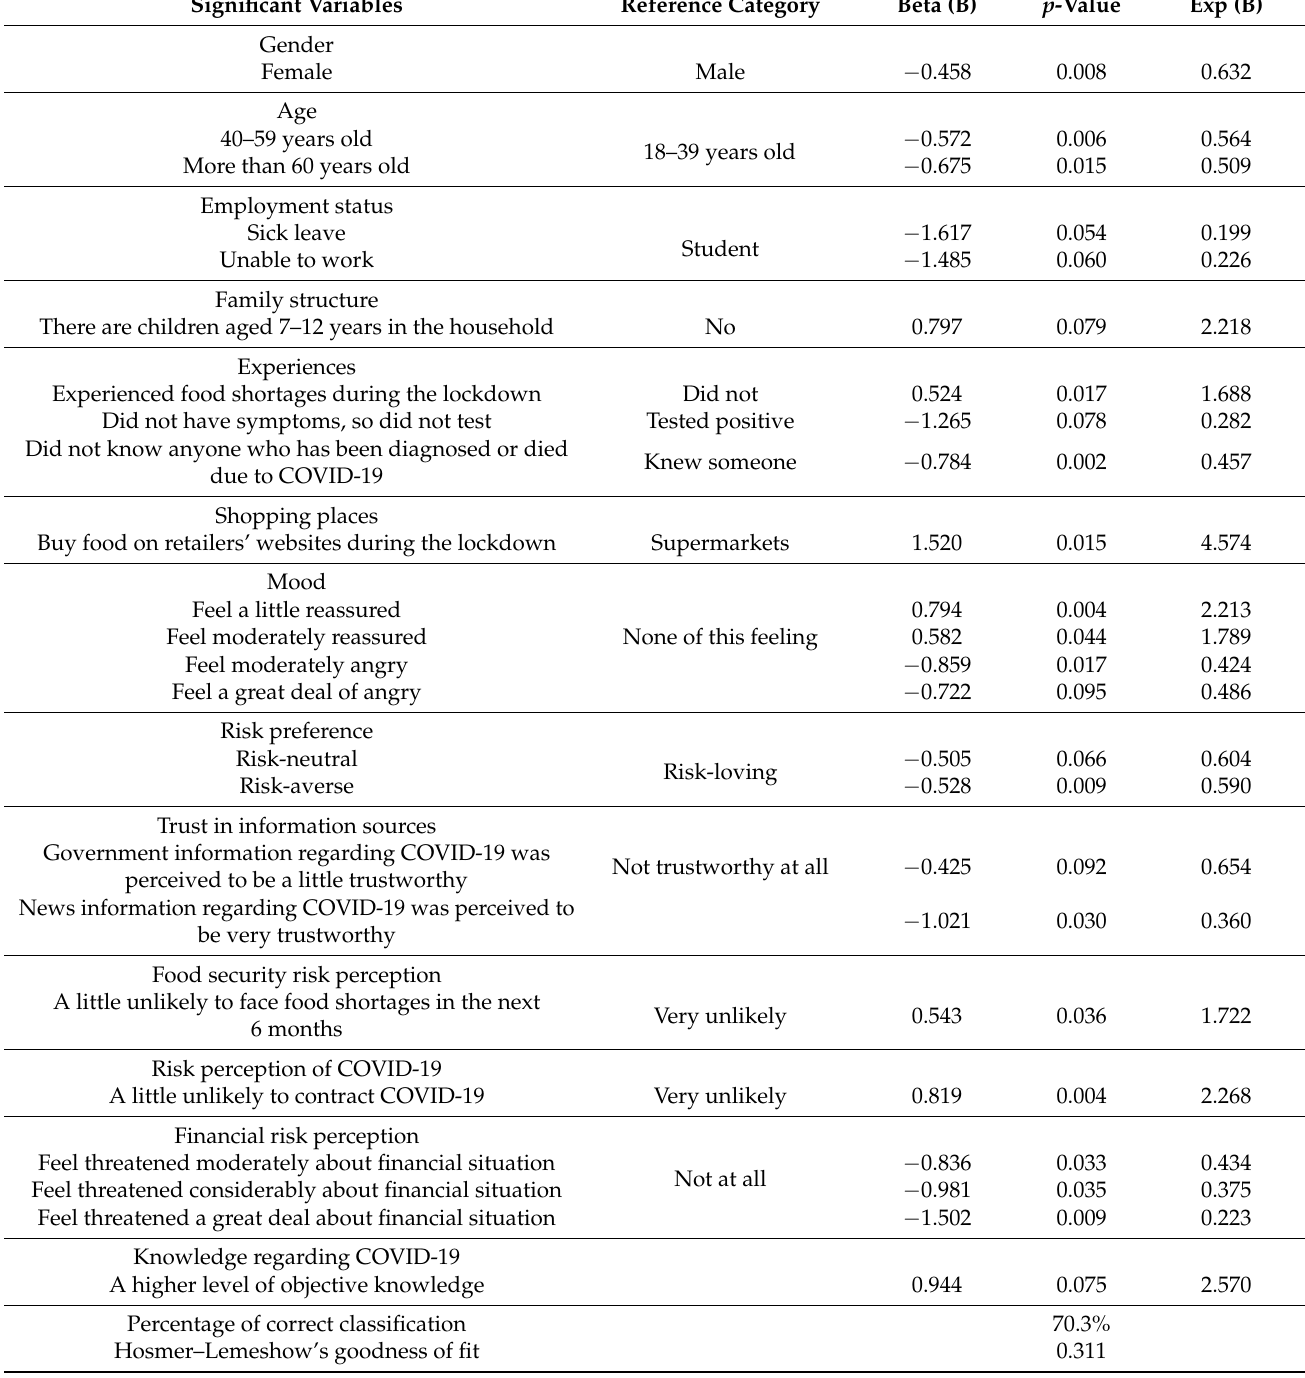
Table 5. Logit model of food expenditure